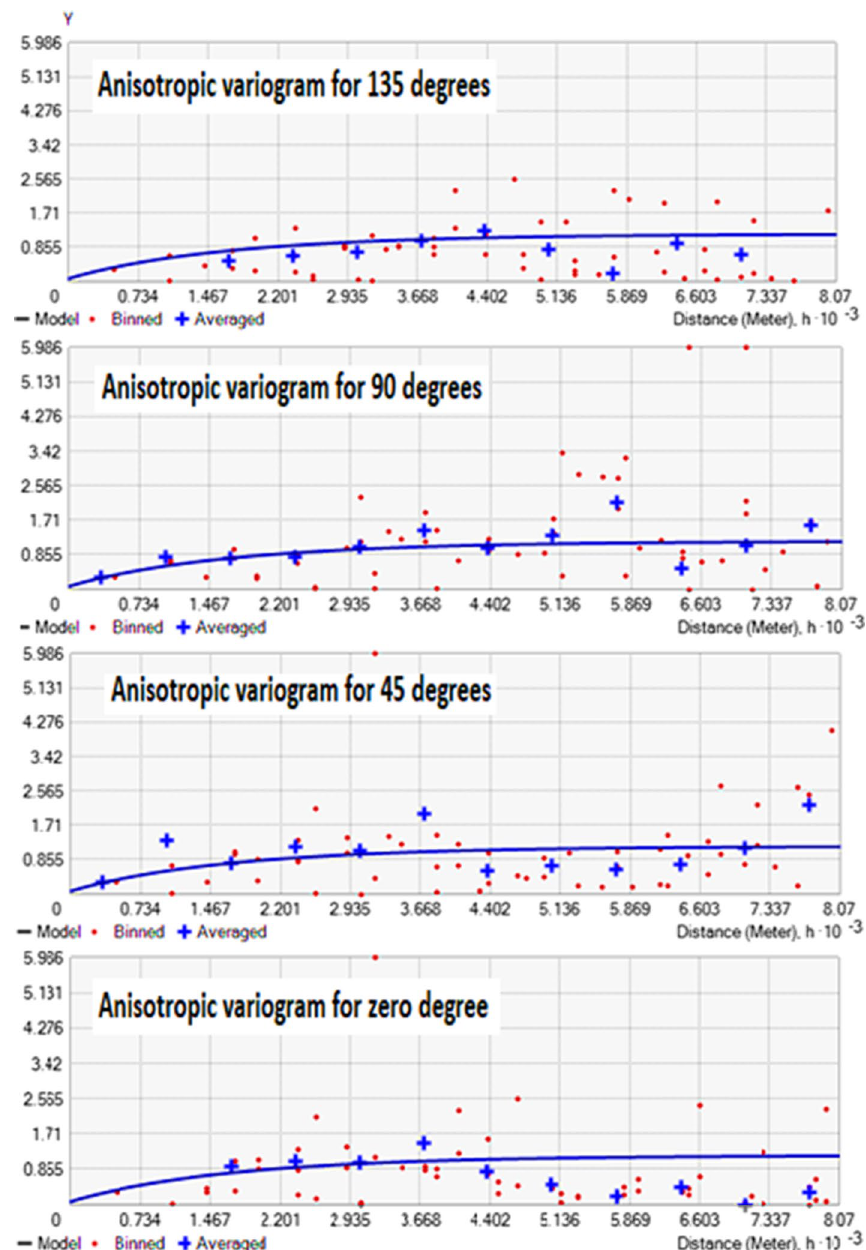
Fig. 5 Estimate of